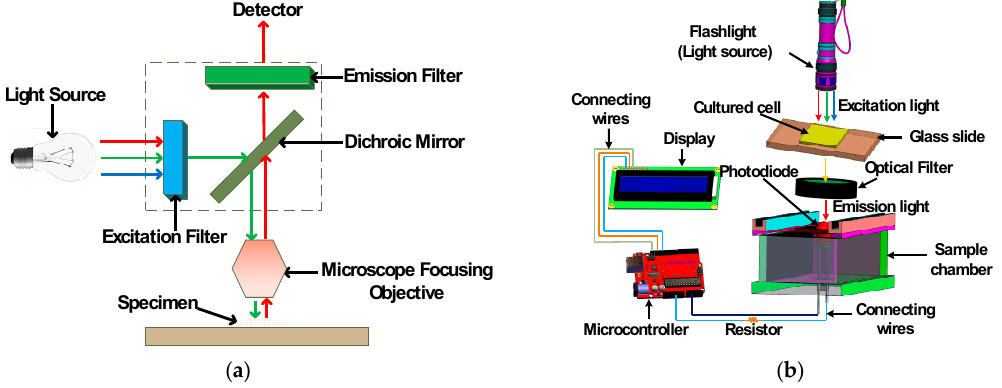
Figure 1. Fluorescence imaging: ( a ) working principle of a typical fluorescence microscope and ( b ) a three-dimensional illustration of the proposed fluorimeter.